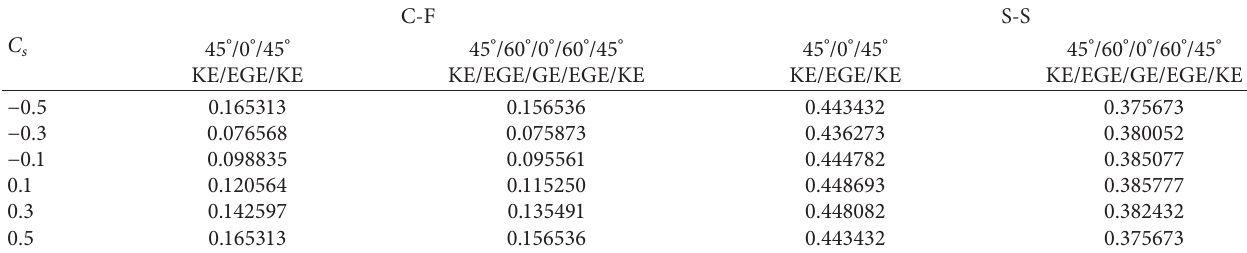
Table 3: Influence of sinusoidal thickness variation on the fundamental frequency parameter of three- and five-layered conical shells with KE/EGE/KE and KE/EGE/GE/EGE/KE material